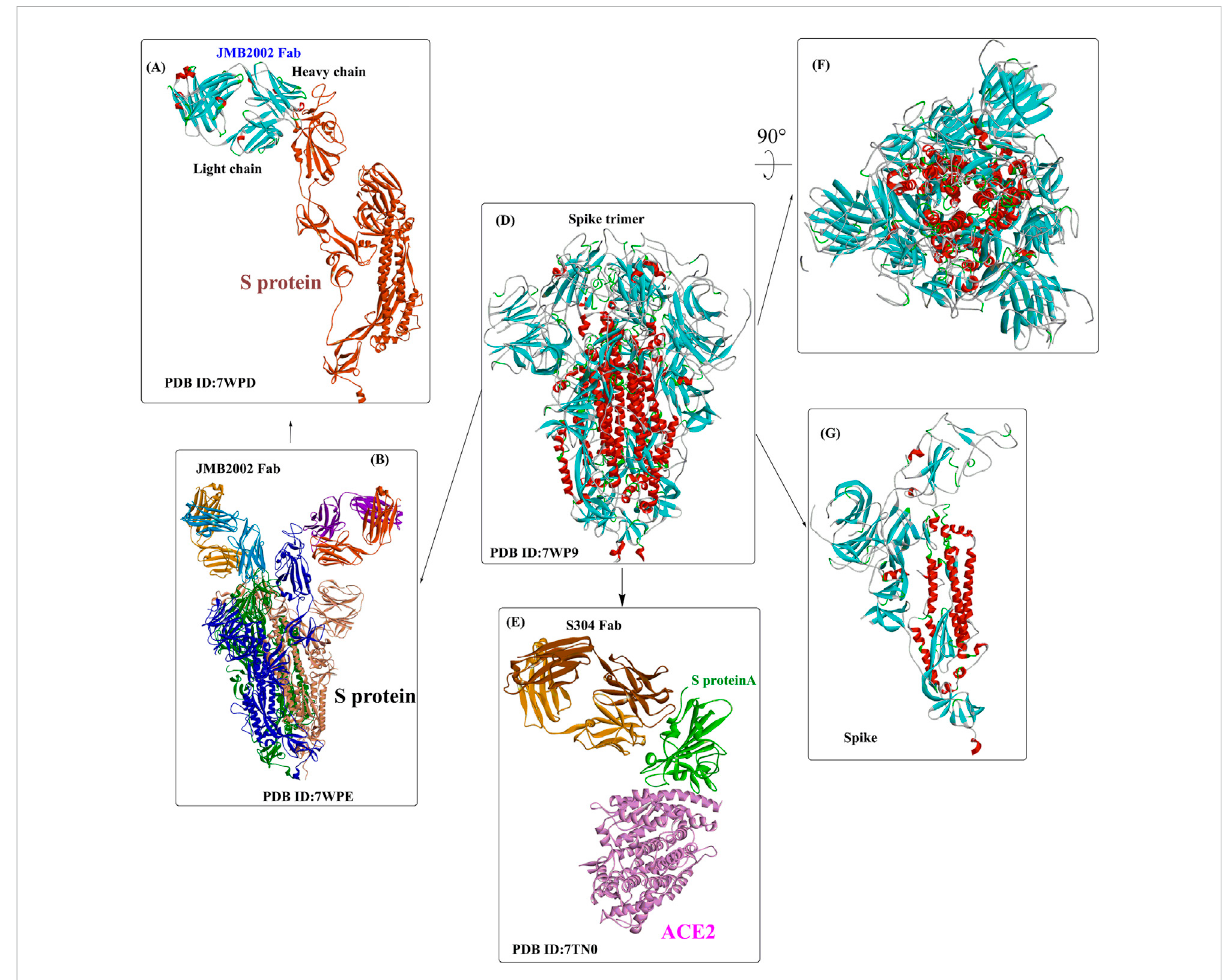
FIGURE 5 The interaction modes of the Omicron spike protein and